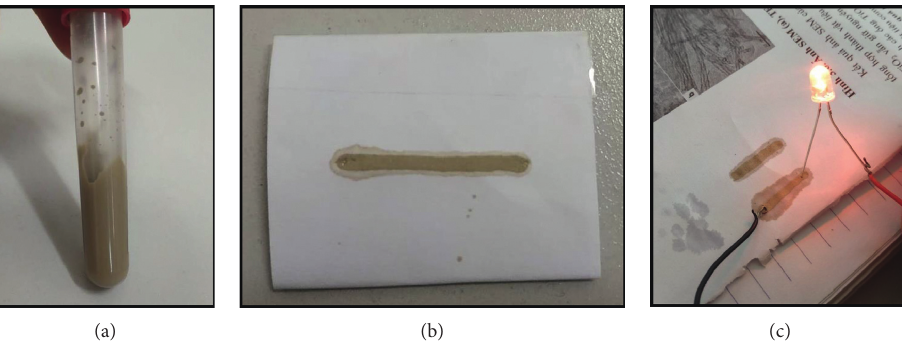
Figure 7: (a) Photo of as-prepared silver paint, (b) a line of silver paint drawn on an A4 paper (70 gram) using a 0.7 mm rollerball pen, and (c) conductivity test using a line of silver paint as a conductor in a circuit to light an LED.